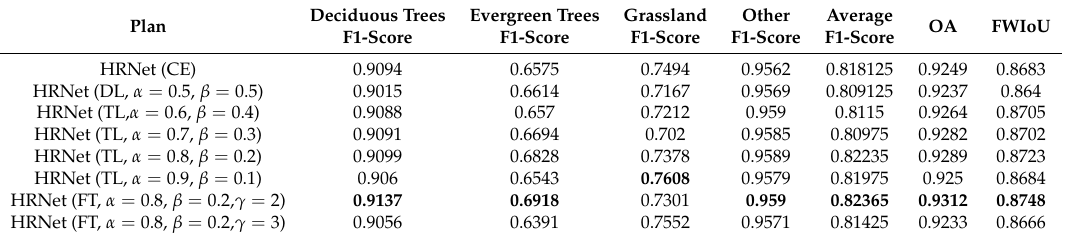
Table 3. Comparison of the accuracy of HRNet with Cross Entropy Loss, Tversky Loss, and Focal Tversky Loss.